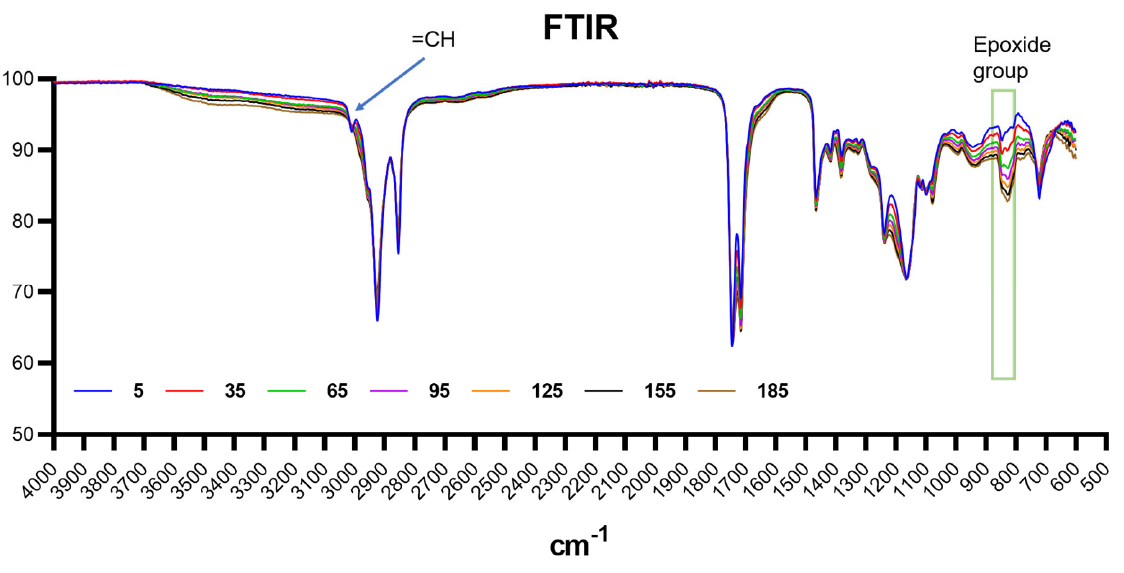
Figure 4. FTIR spectra of ECSO (epoxidized cottonseed oil) at different reaction times (5, 35, 65, 95, 125, 155, and 185 min) performed at 70 °C.